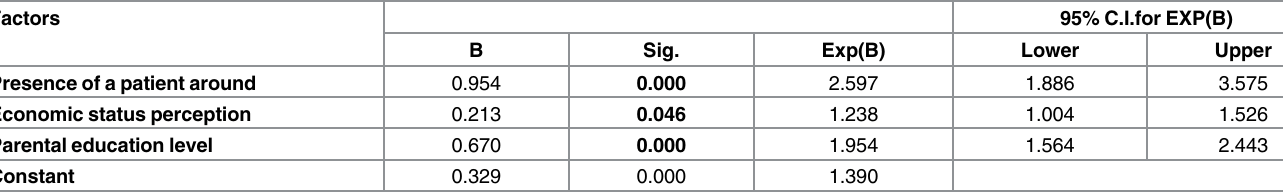
Table 3. Factors affecting the status of being previously informed.